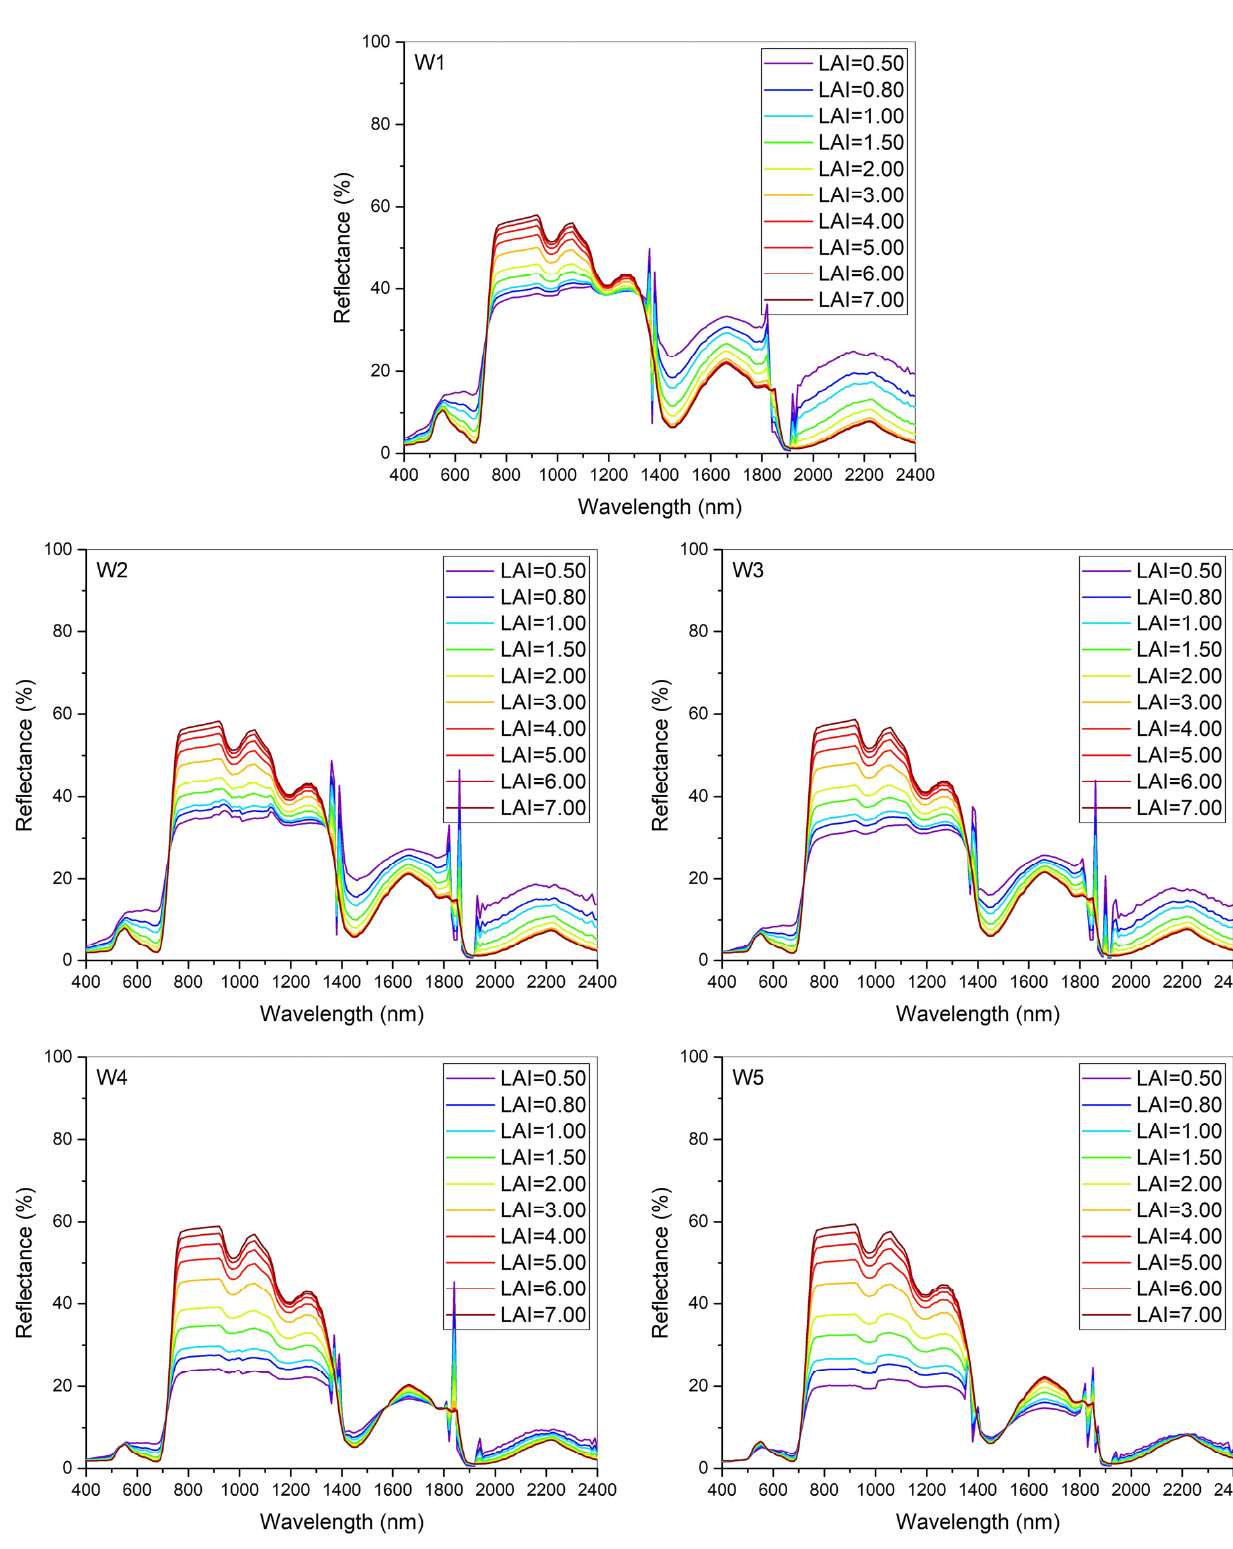
Figure 6. Influences of different LAI on canopy spectral reflectance under continuous water stresses.